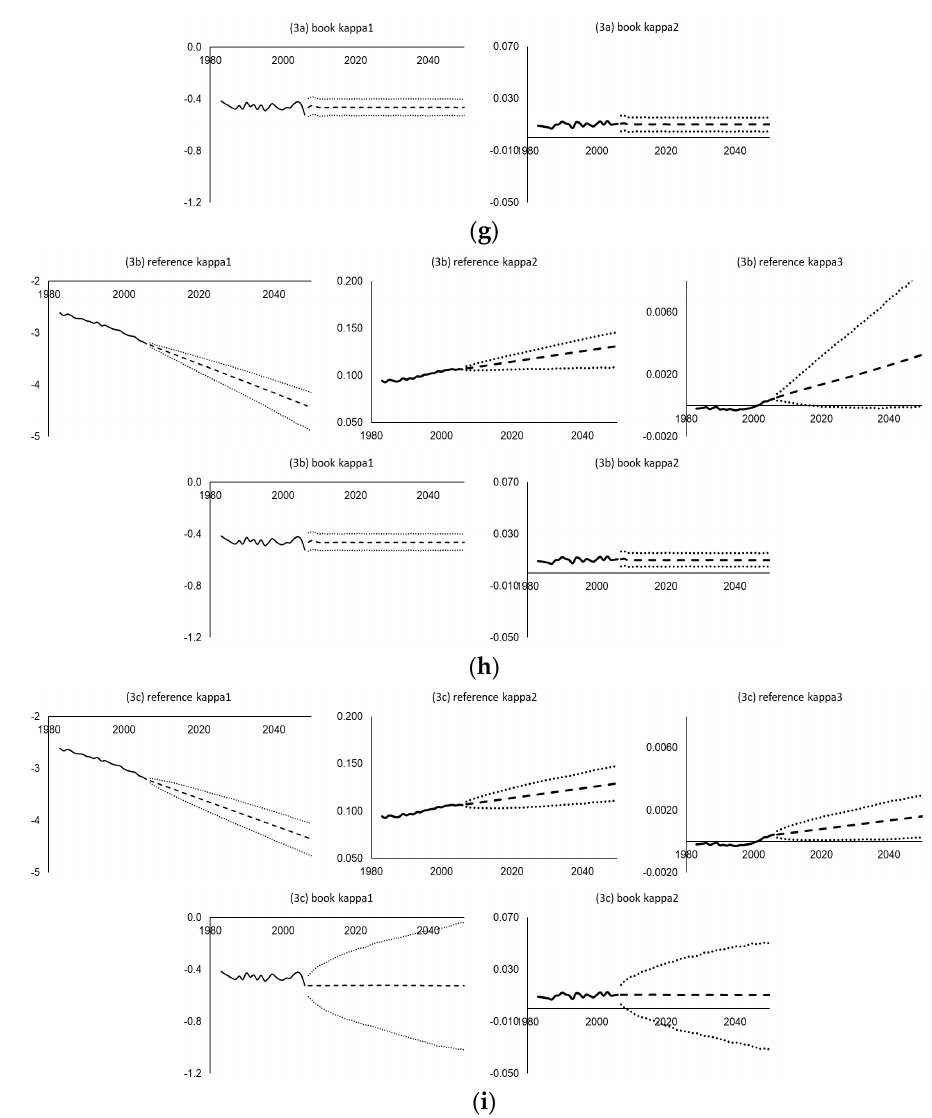
Figure 5. Time series projections and 95% prediction intervals from (bivariate) residuals bootstrapping using assured lives (book) data and England and Wales (reference) data. ( a ) Model (1a): Lee–Carter model with cohort with bivariate random walk with drift; ( b ) Model (1c): Lee–Carter model with cohort with VECM( p ); ( c ) Model (1d): Lee–Carter model with cohort with VARIMA( p ,1,0); ( d ) Model (2a): Generalized common factor model with cohort with independent AR(1); ( e ) Model (2c) Generalized common factor model with cohort with correlated AR( p ); ( f ) Model (2d) Generalized common factor model with cohort with VAR( p ); ( g ) Model (3a): Extended CBD model with cohort with multivariate random walk with drift and VAR( p ); ( h ) Model (3b): Extended CBD model with cohort with VARIMA( p ,1,0) and VAR( p ); ( i ) Model (3c): Extended CBD model with cohort with multivariate random walk with drift and bivariate random walk without drift.